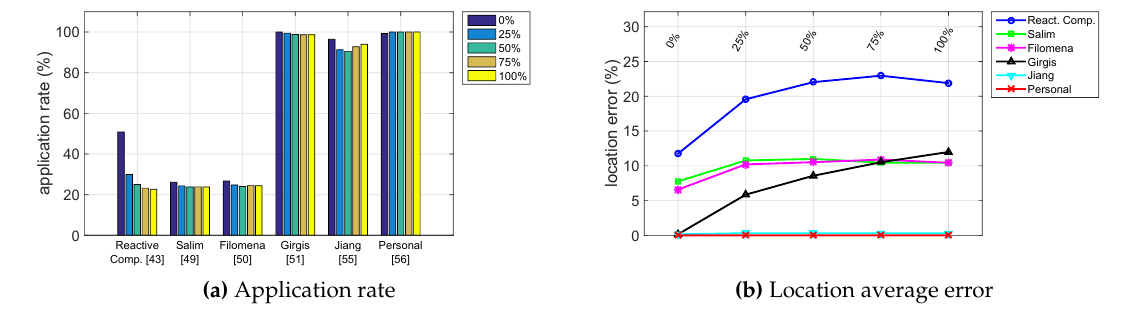
Figure 18. Applied load percentage